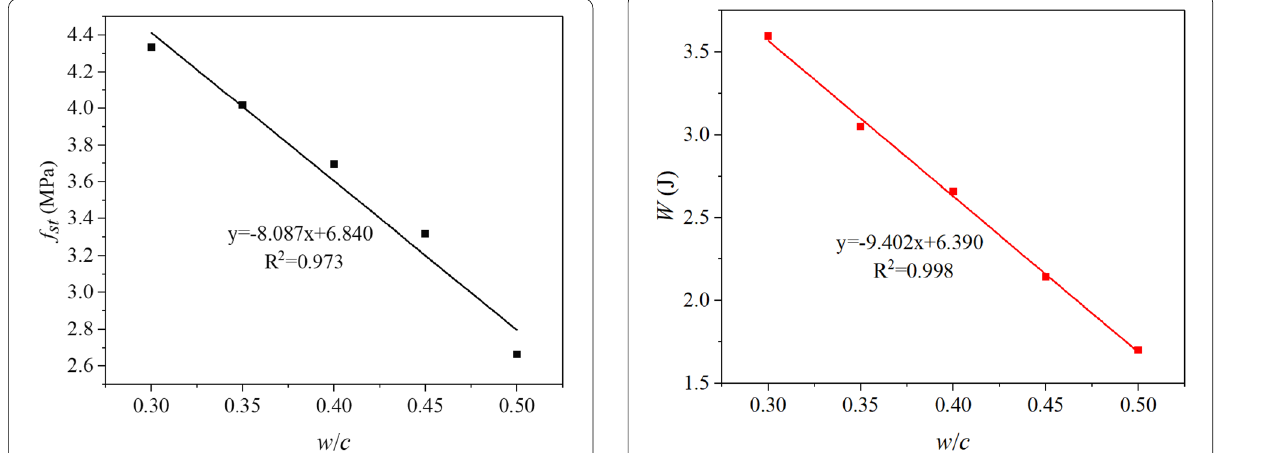
Fig. 14 Variation of concrete tensile strength with water–cement ratio